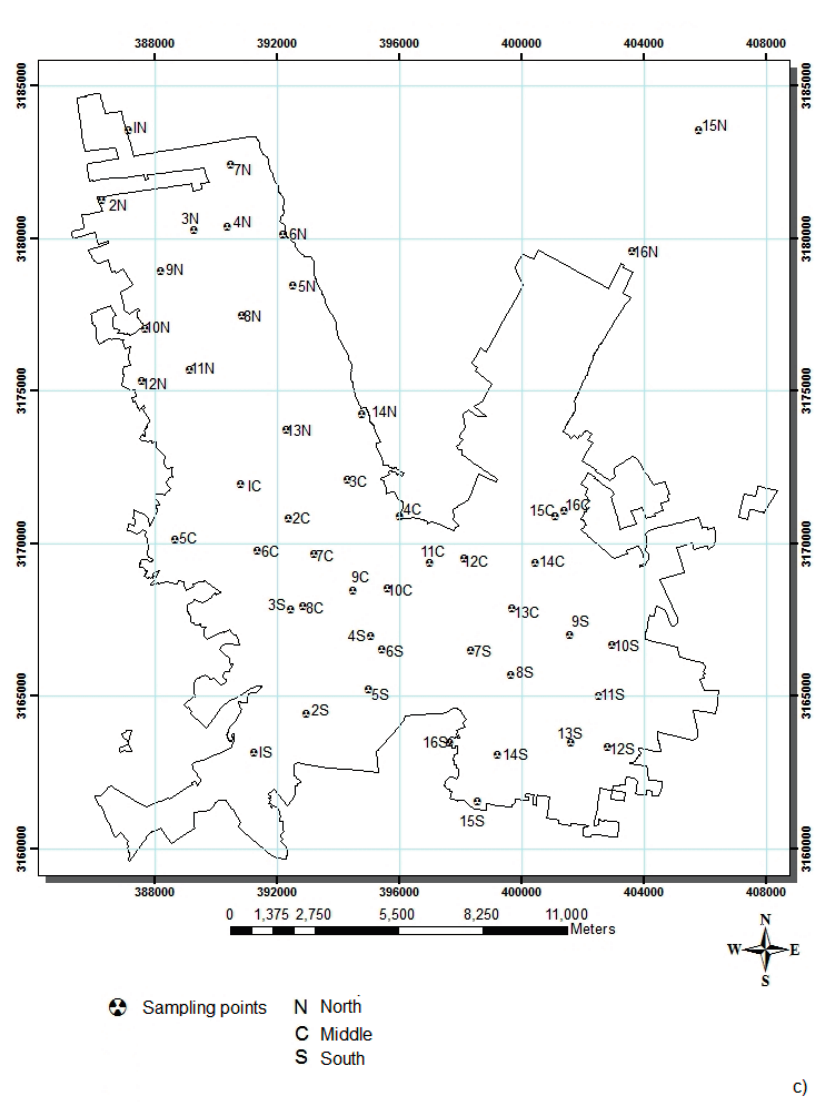
Figure 1. Study area: ( a ) localization; ( b ) uranium ore deposits (in red); and ( c ) sampling